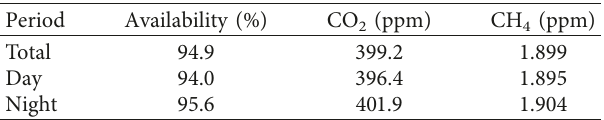
Table 2: Vegetation types following NDVI values ∗ . NDVI